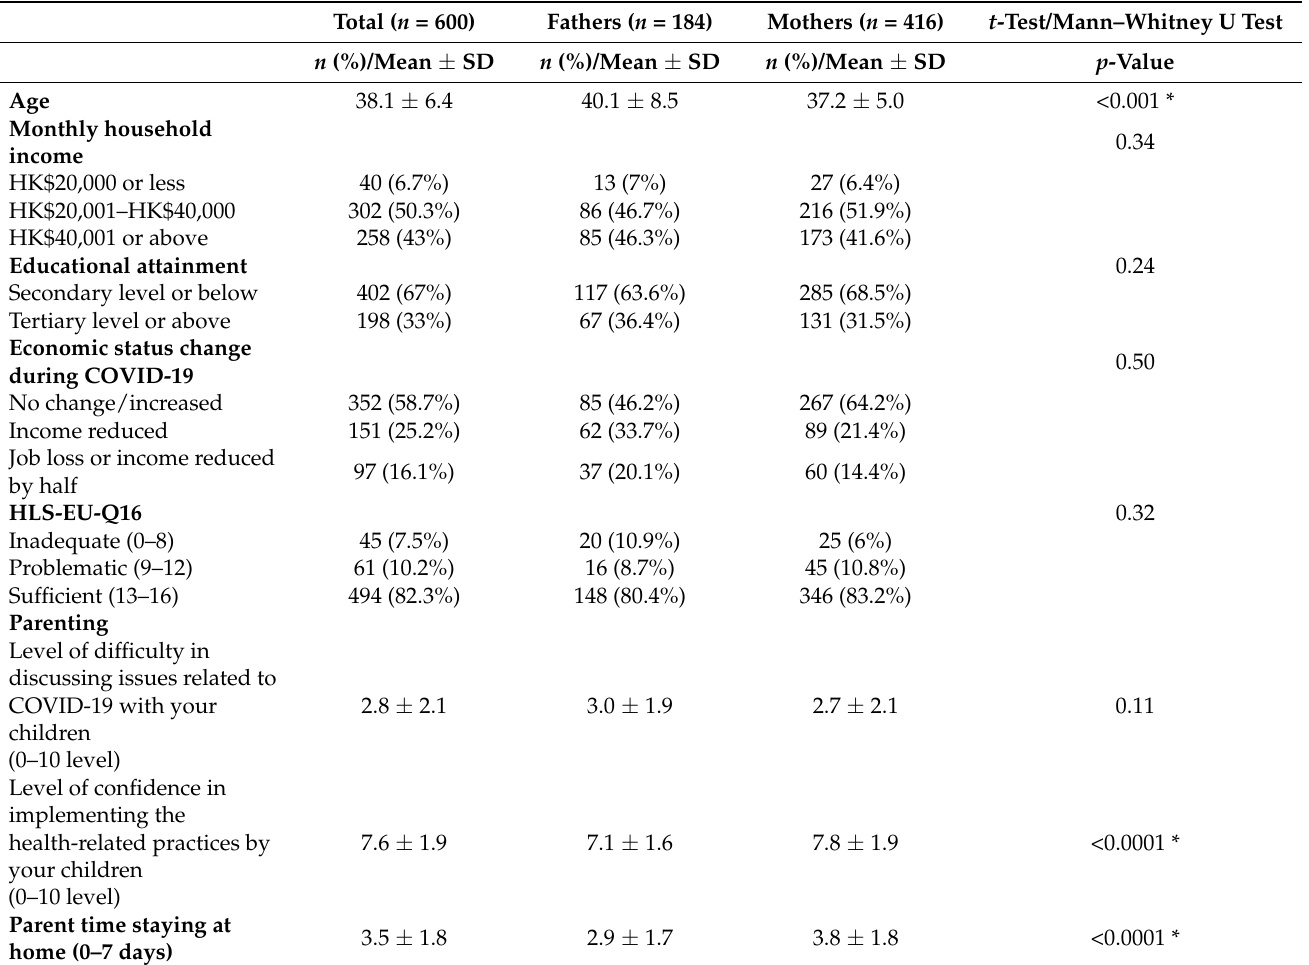
Table 1. Participant